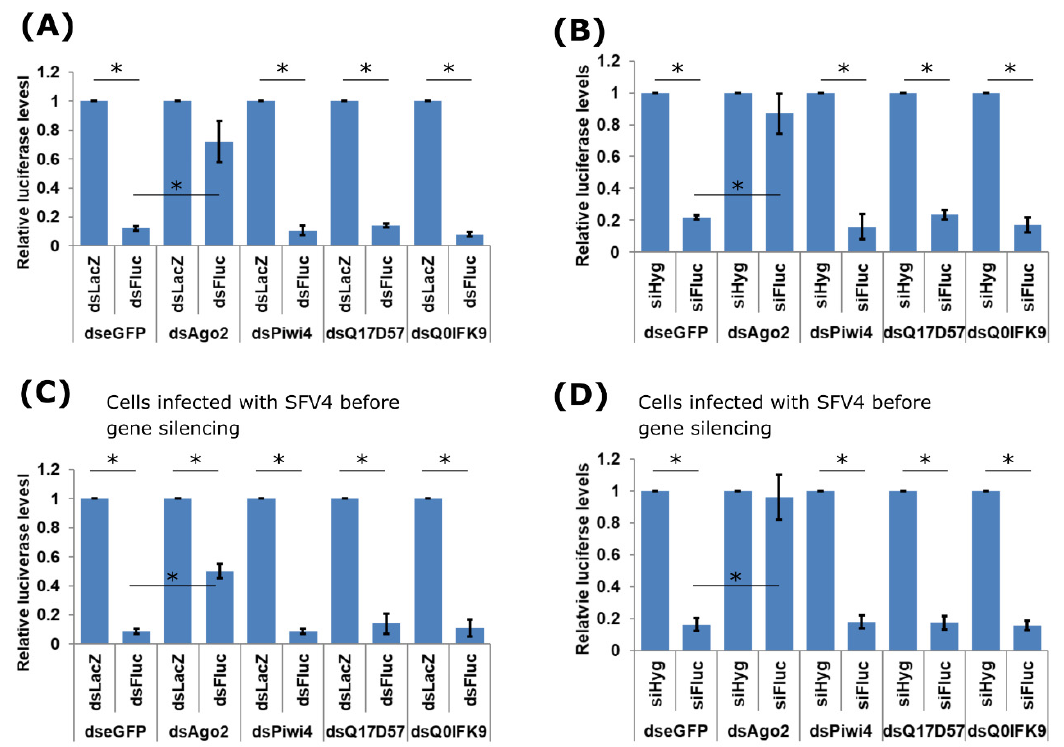
Figure 4. Effect of Q17D57 and Q0IFK9 knock down on the exo-siRNA pathway. Aag2 cells were transfected with ( A , B ) dsRNA targeting eGFP (control), Ago2, Piwi4, Q17D57 or Q0IFK9, or ( C , D ) first infected with SFV4 at MOI 10 followed by dsRNA transfection 6 h later. After 48 h, cells were co-transfected with FFLuc (pIZ-Fluc) and Rluc (pAcIE1-Rluc) expressing reporter plasmids and ( A , C ) dsRNAs against FFLuc (dsFluc) or LacZ (dsLacZ) (as control) or alternatively, ( C , D ) small interfering RNAs (siRNAs) targeting FFLuc (siFluc) or Hygromycin B resistance gene (siHyg) (as control) to assess the silencing ability of siRNAs and bypass the necessity for Dcr2 processing. Cells were lysed at 24 h p.t., and luciferase activities determined. Relative luciferase levels are shown on the Y-axis (with FFLuc / Rluc ratio in dsLacZ or siHyg transfected cells set to 1). The mean values with standard error are shown for three independent experiment conducted in triplicate, * indicates significance, p < 0.05 (Student’s two-tailed t -test).